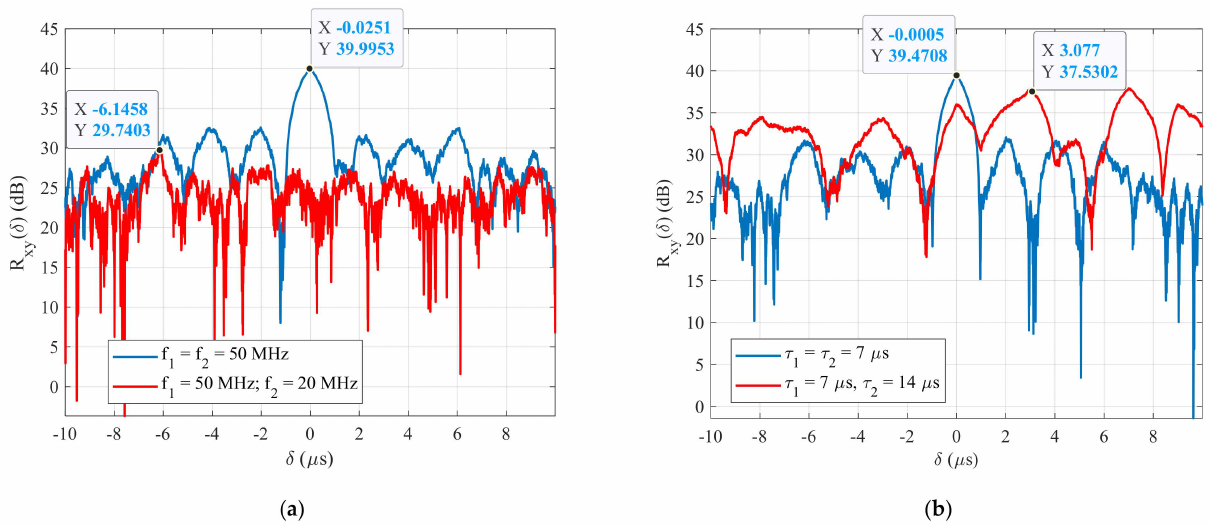
Figure 2. The CCF between two BPSK signals at an SNR = − 20 dB; ( a ) carrier frequency, and ( b ) pulse